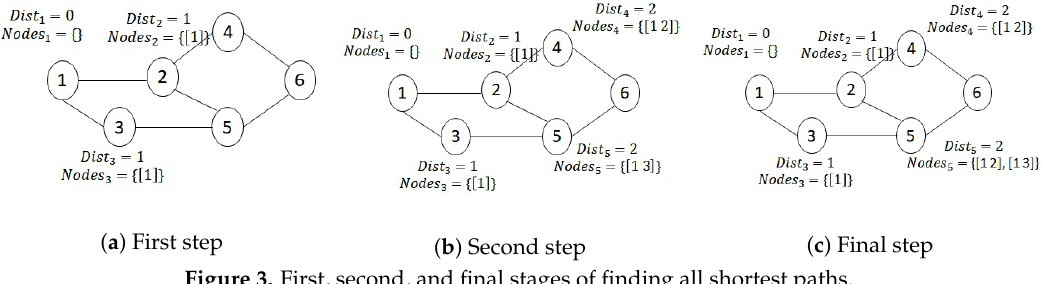
Figure 3. First, second, and final stages of finding all shortest